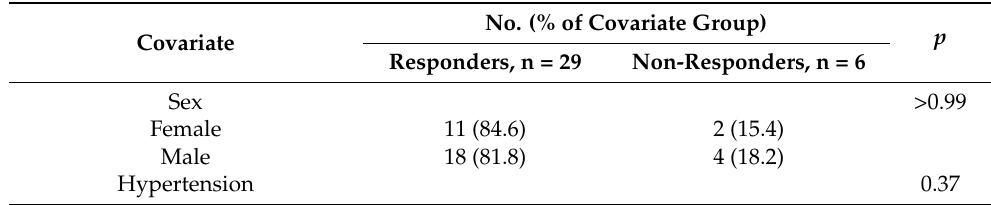
Table 2. Association of baseline clinical characteristics with response to treatment for immune checkpoint inhibitor–induced acute interstitial nephritis (at 3 months after initiation of treatment). No. (% of Covariate Covariate